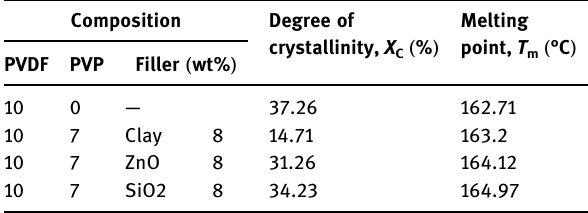
Table 1: Thermal Properties and Crystallinity of PVDF